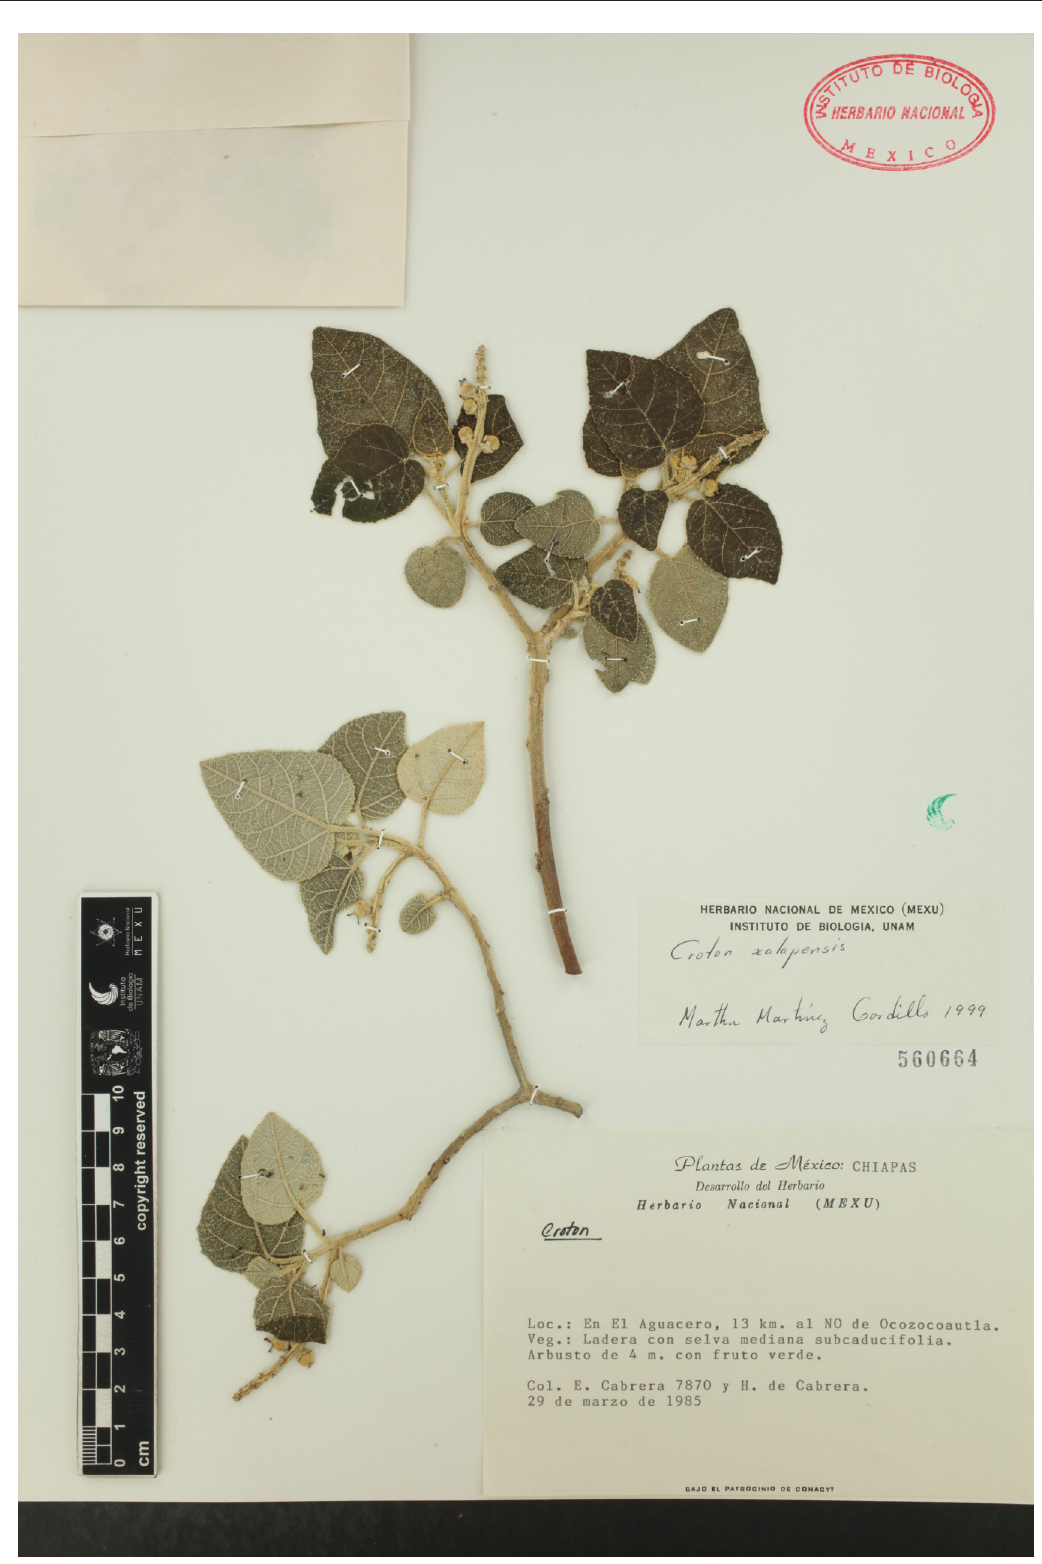
Fig. 3. Image of one of the paratypes of Croton calcareus Riina & Mateo-Ram. sp. nov. ( Cabrera and Cabrera 7870 , MEXU), previously indentified as C. xalapensis Kunth, to show the variation in leaf shape and indumentum density. It also shows immature fruits (younger than those in the type